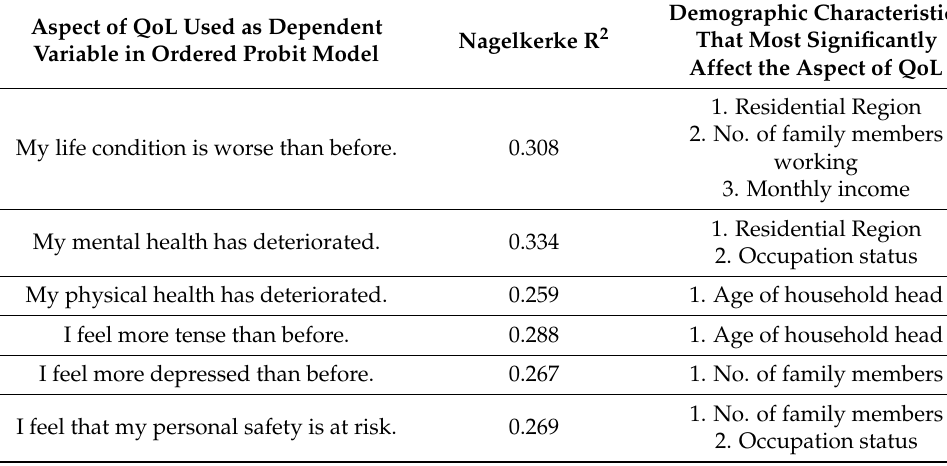
Table 7. Summary of ordered Probit models on the aspects of quality of life that are driven by demographic characteristics of